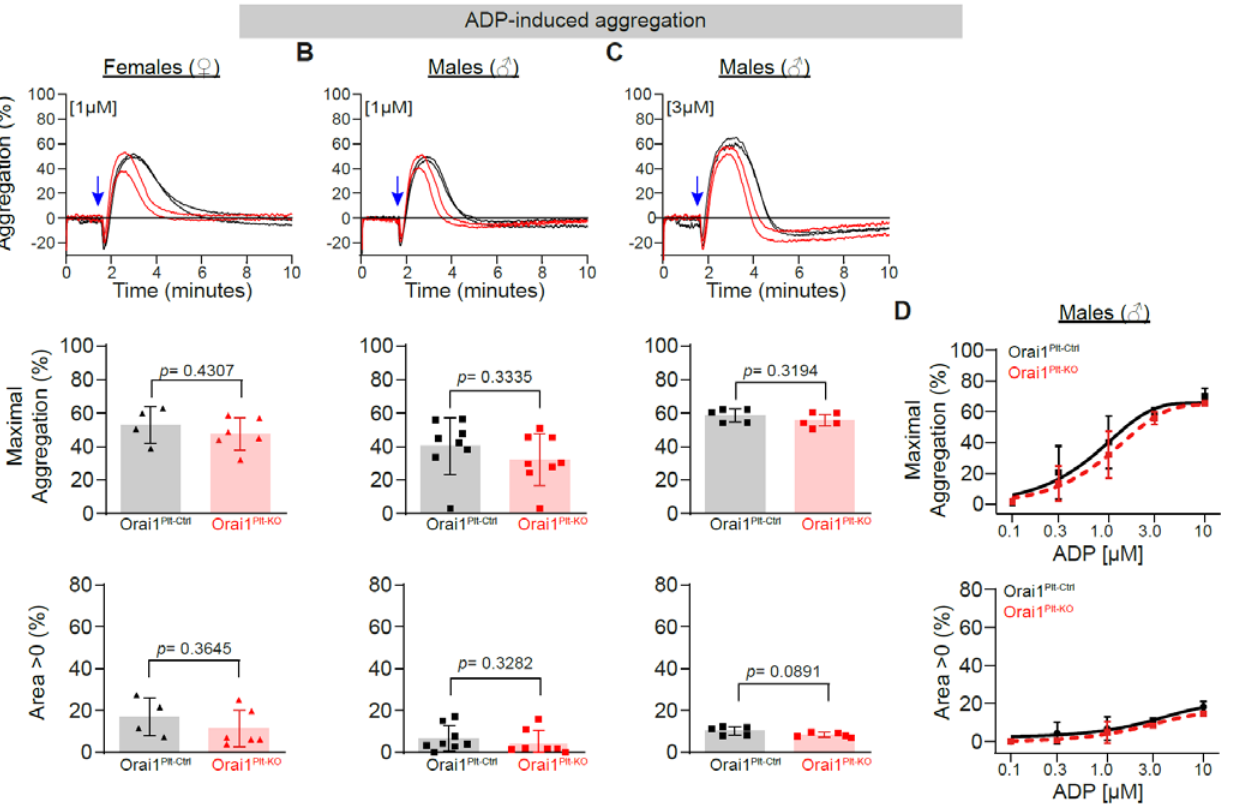
Figure 4. Preserved ADP-induced platelet aggregation in Orai1 deficient platelets. ADP-induced platelet aggregation in washed platelets from Orai1 Plt-Ctrl (black) and Orai1 Plt-KO (red) mice was ana- lysed ( A – D ). Representative original aggregation traces (upper panels), analysis of maximal aggre- gation (middle panels) and area under the aggregation curve (lower panels) after stimulation with 1 µM ADP of platelets from female ( A ) or male ( B ) mice; similarly, analysis in platelets from male mice stimulated with 3 µM ADP are depicted ( C ). Dose-response curves for the maximal aggrega- tion (upper panel) and the area under the aggregation curve (lower panel) after ADP stimulation of male platelets are shown ( D ). Each dot in ( A – C ) corresponds to one independent platelet prepara- tion. In ( D ) numbers of independent platelet preparations per ADP concentration were: 0.1 µM = 3, 0.3 µM = 5, 1 µM = 8, 3 µM = 5 and 10 µM = 3. Blue arrows indicate the agonist stimulation time point. Error bars indicate SD. p -values were calculated according to the unpaired Student’s t -test (Panels A, B and C − except for Area > 0 of ADP 1 µM from male mice − ) or Mann-Whitney U test (Area > 0 of ADP 1 µM from male mice) after Shapiro-Wilk normality test.